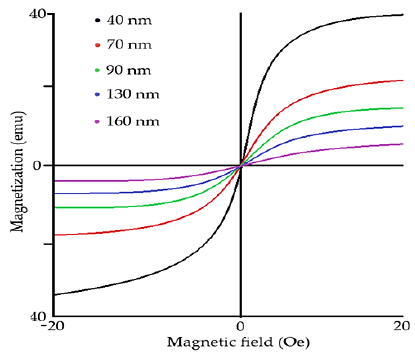
Figure 4. Hysteresis loop of various particle sizes of BFO material.